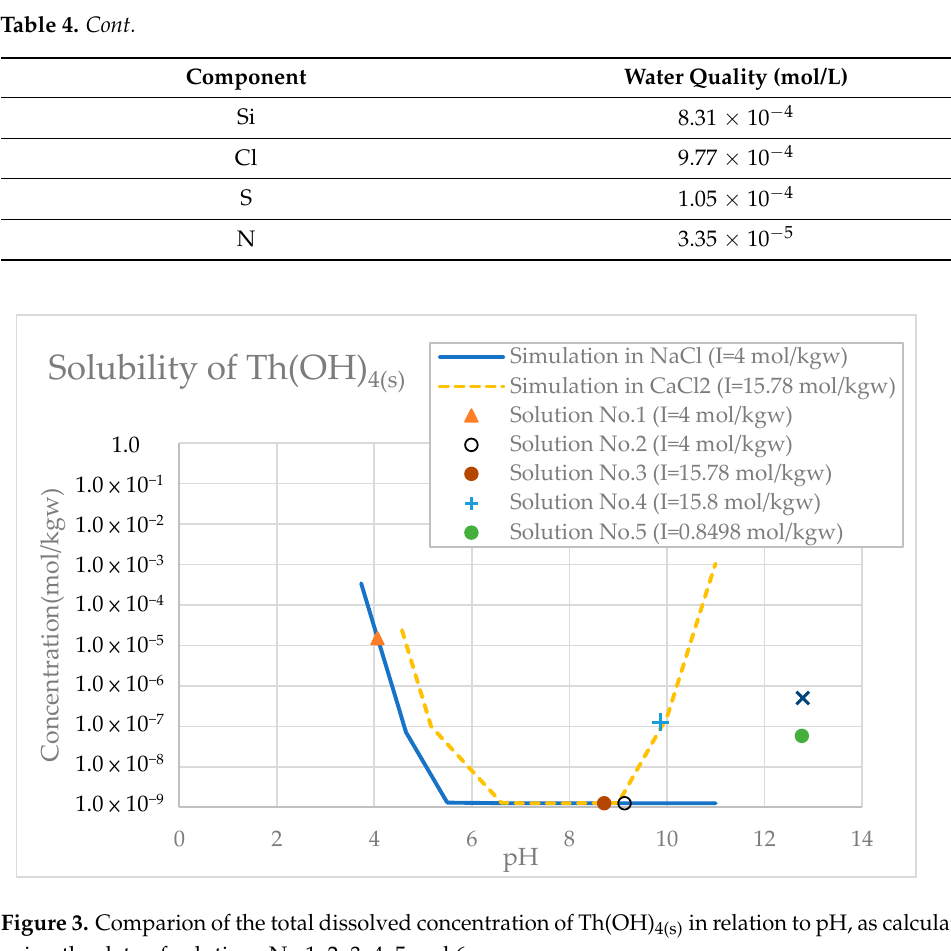
1.0E-091.0E-081.0E-071.0E-061.0E-051.0E-04